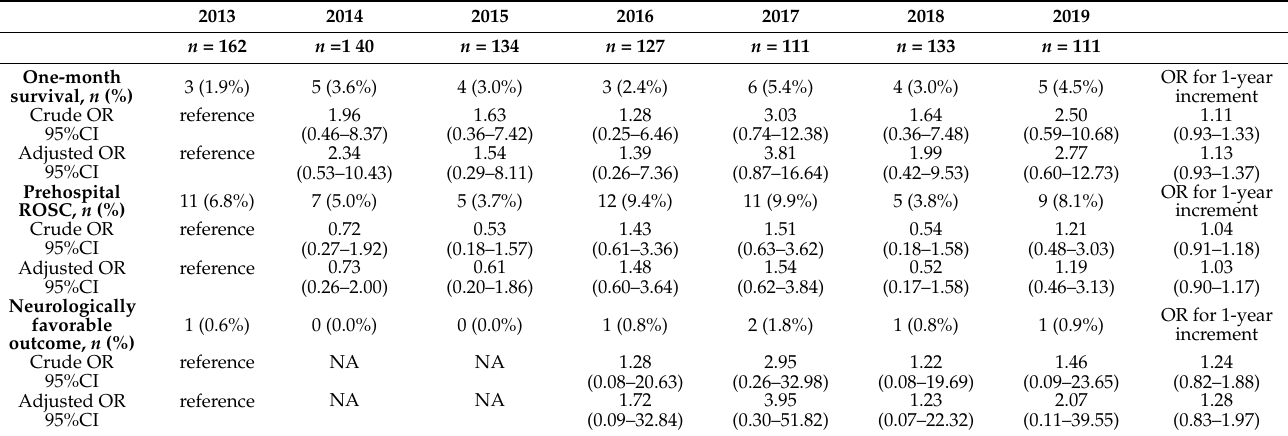
Table 2. Annual trends in primary and secondary outcomes of traumatic out-of-hospital cardiac arrests after traffic